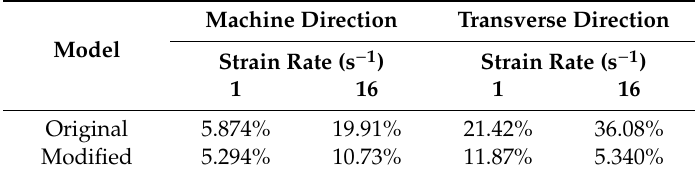
Table 4. Comparison in observed root mean squared errors (%RMSE) between predicted and observed stress–strain behaviour, for the modified and original Buckley material model, at a temperature of 130 ◦